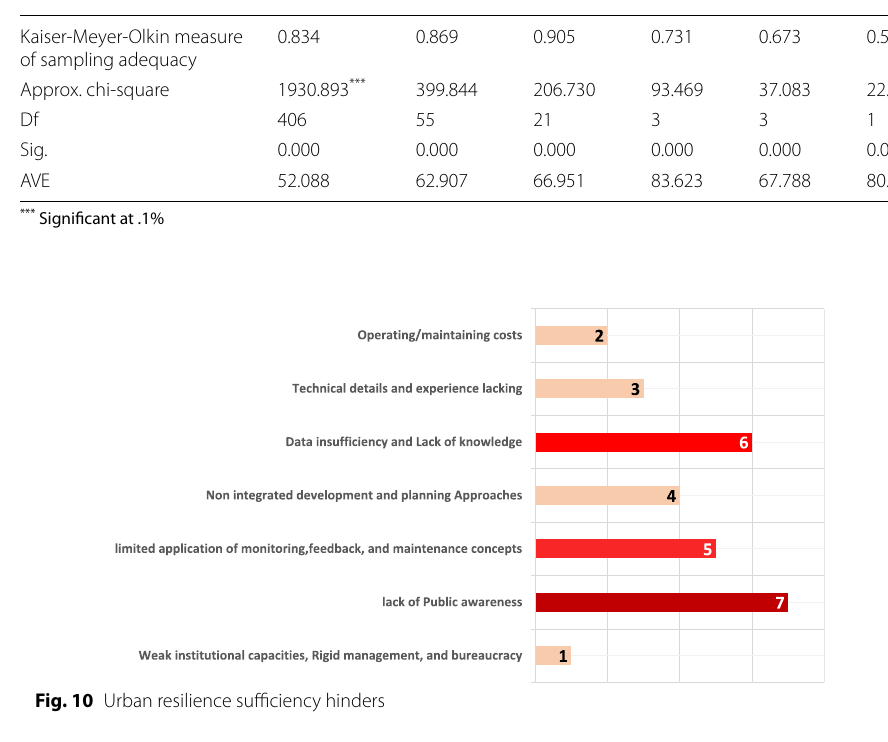
Table 5 Component score coefficient matrix Dimensions